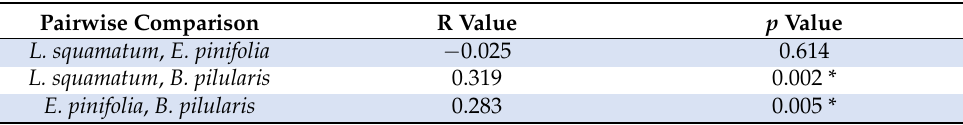
Table 9. Pairwise comparisons between plant assemblages. An asterisk denotes significance using